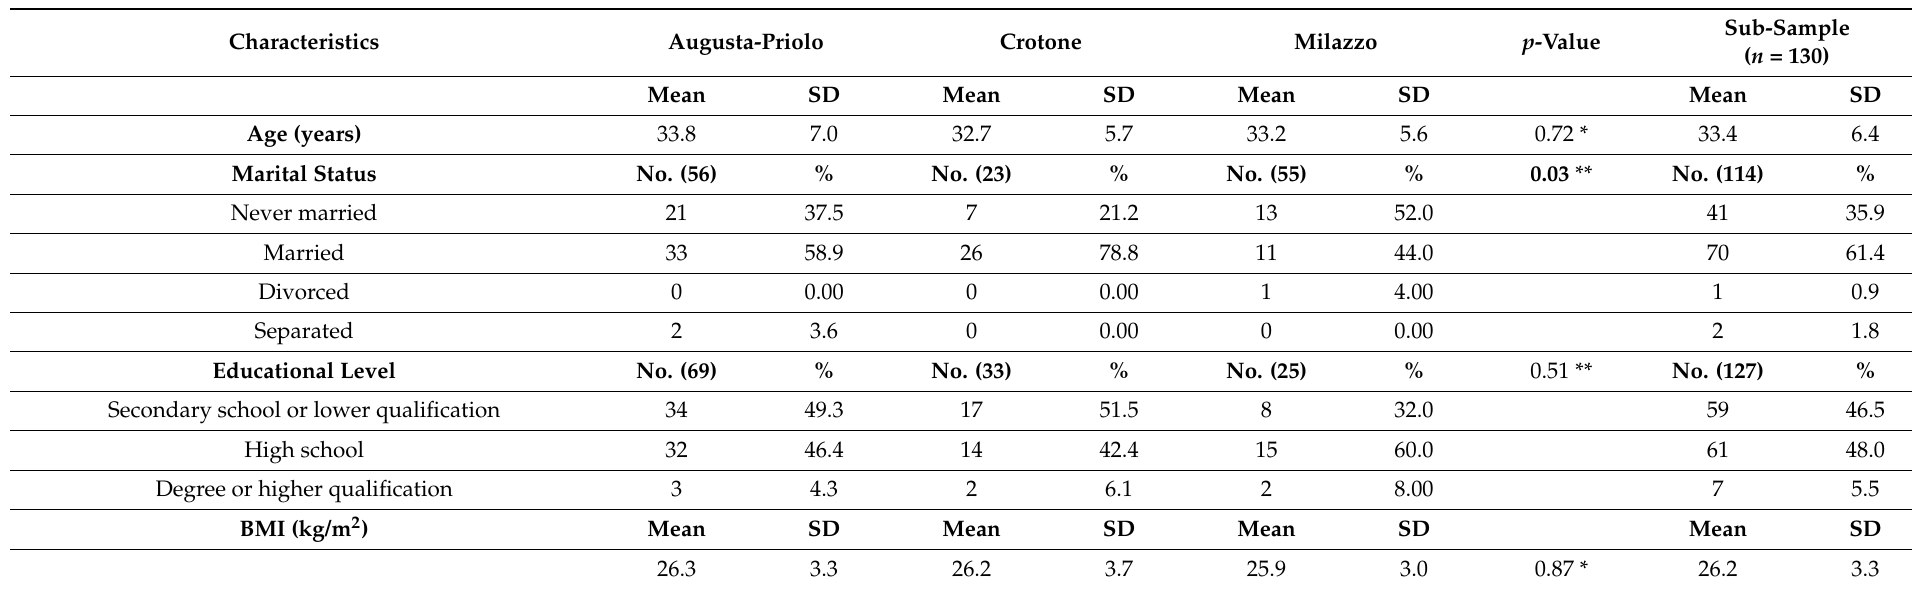
Table 5. Characteristics of the dropout fathers in the total subsample and in each NPCS: continuous variables are reported as mean ± SD, while categorical variables are reported as numbers and percentages. Significant p -values are in bold. For each categorical variable, in parentheses, the total number of responders is indicated.